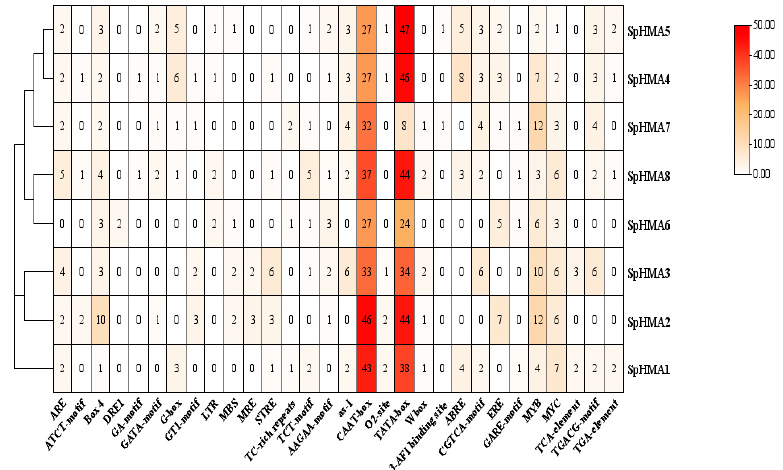
Figure 4. Cis-acting elements in promoters of SpHMA genes. All the predicted promoter region is 2000 bp. The different colors of grid represent the different number of promoters and the specific numbers are marked in it.